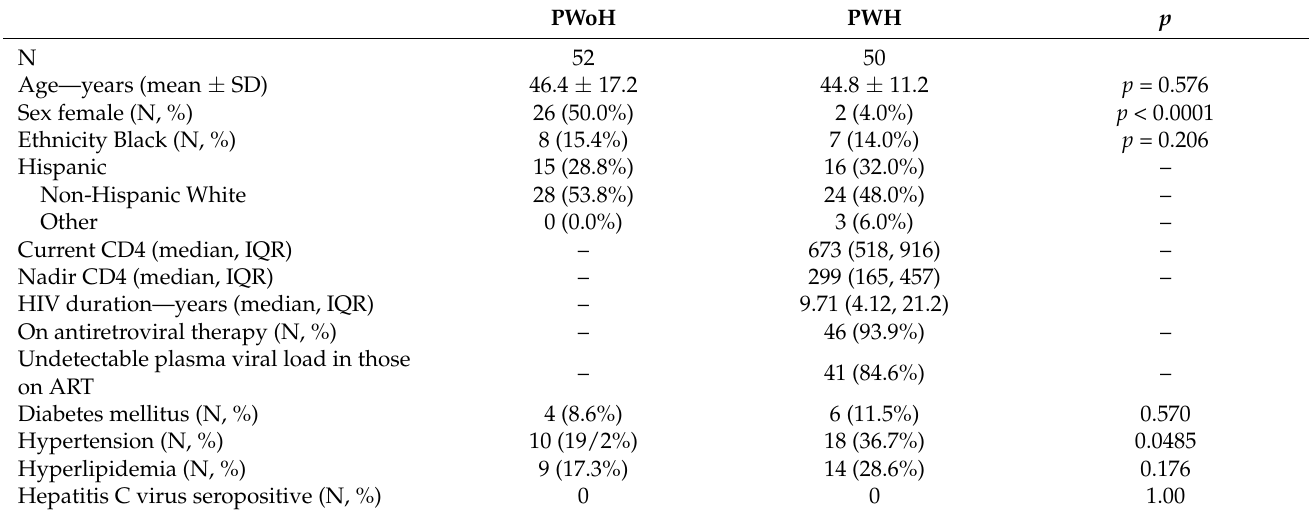
Table 1. Demographic and clinical characteristics of the study participants.